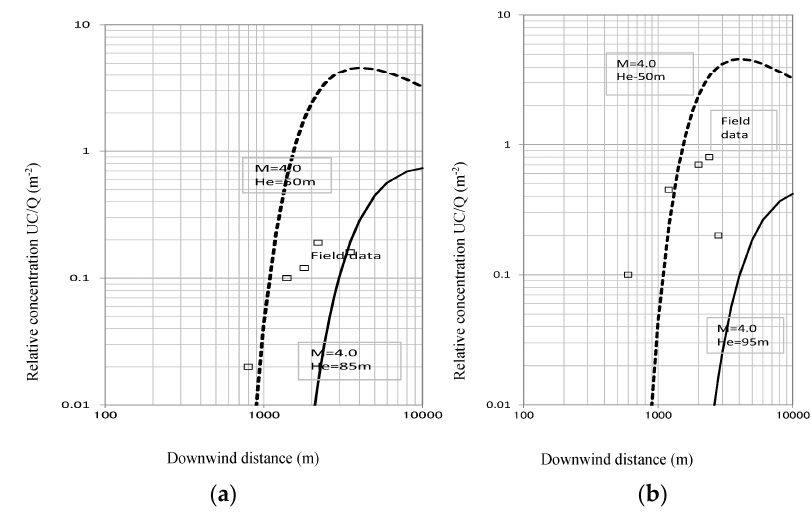
Figure 14. Comparison of calculated concentrations with field data under stable conditions (category F); option 1 is represented by a solid line, option 2 by a dashed line. ( a ) Run No. 90-4 (F); ( b ) Run No. 90-5 (F).